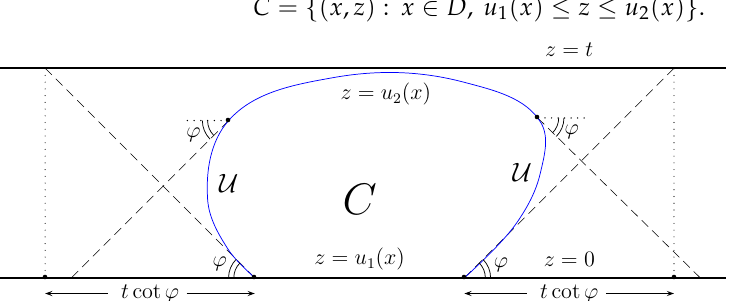
Figure 3. The body C between two parallel planes z = 0 and z = t is shown. Here, by the union of two curves bounded by the Figure 3: The body C between two parallel planes z = 0 and z = t is shown. Here represented by the union of two curves bounded by the points.